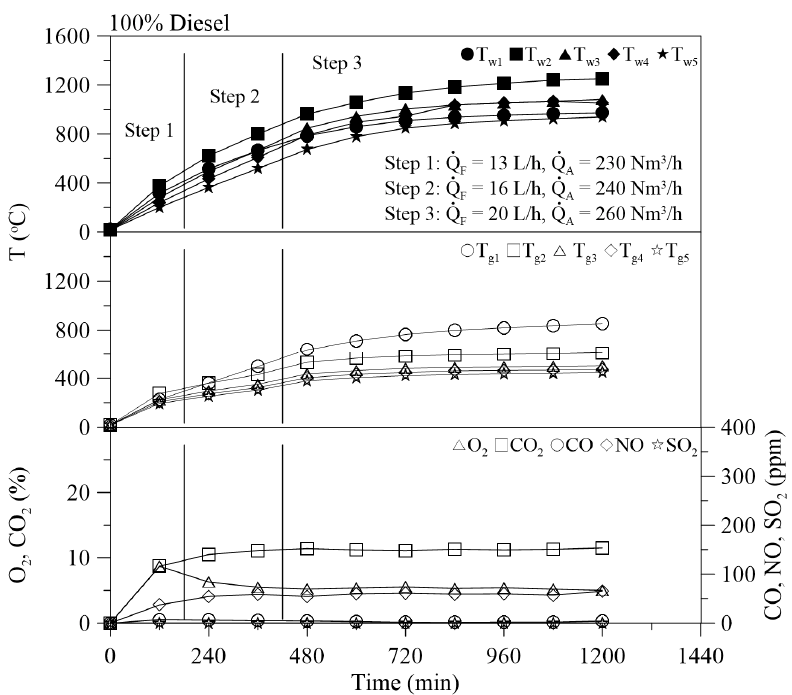
Figure 3. Variations in wall temperature, gas temperature and emissions with burning time using diesel as the fuel during the preheating process.